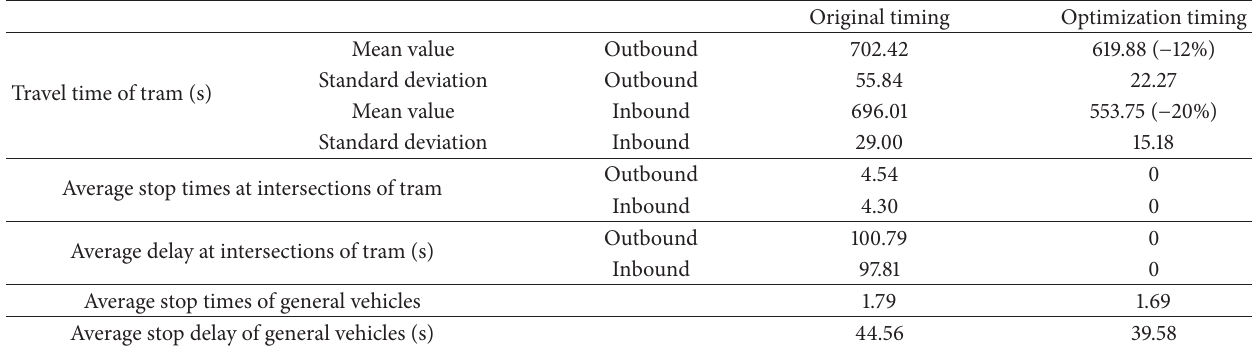
Table 4: Simulation results of original timing plan and optimization timing